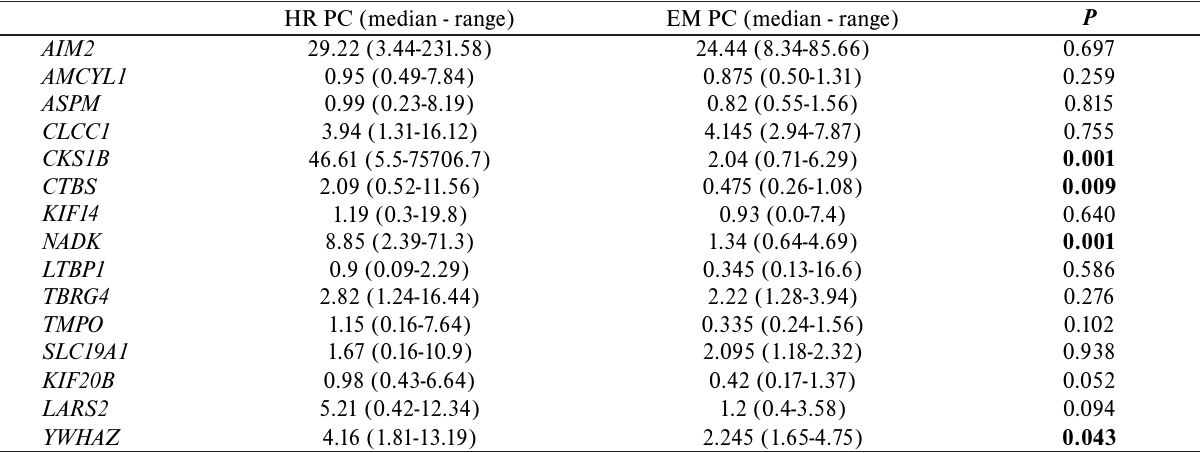
Table 3a. Comparison of gene expression between HR PC and EM PC groups.